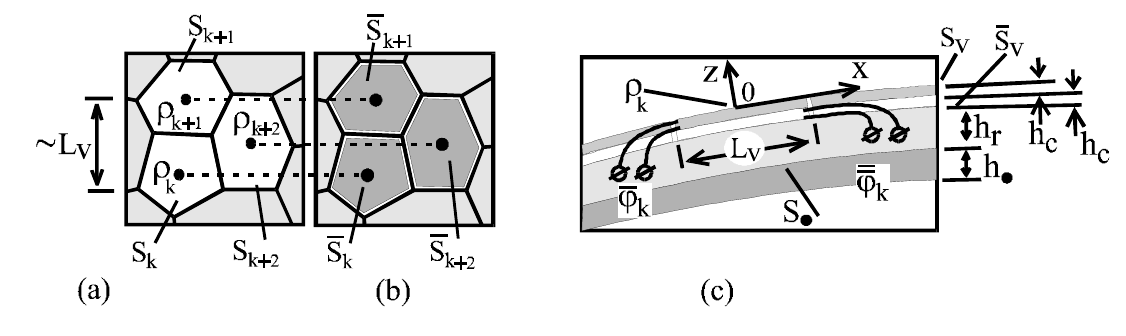
Figure 6. Tangential (a, b) and cross-section (c) structure of the protected body and active